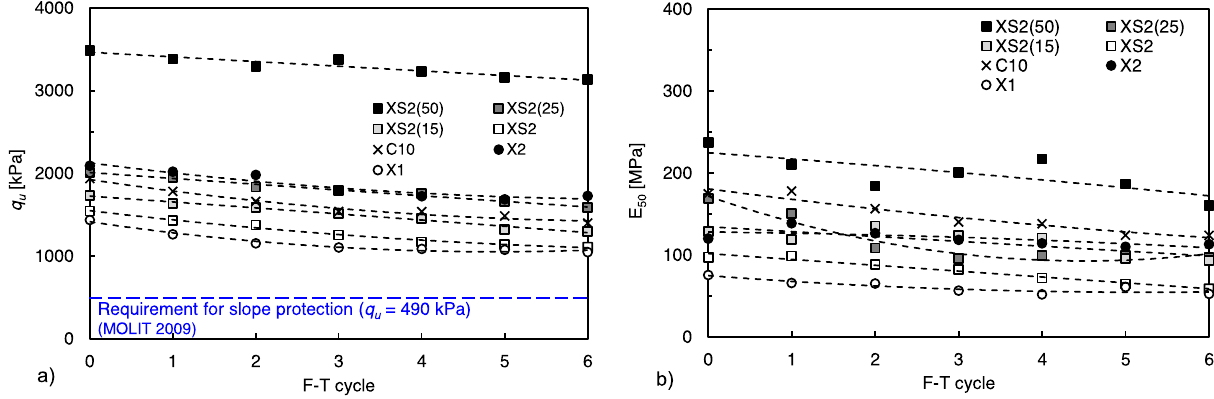
Figure 12. Cyclic W–D durability test result. ( a ) q u and ( b ) E 50 .